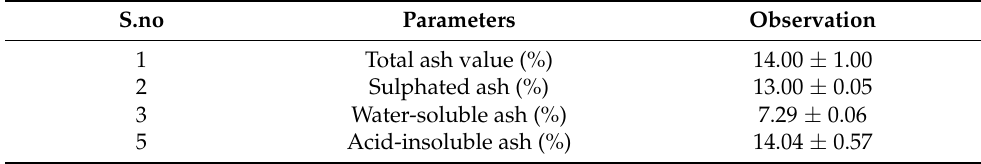
Table 3. Details of ash values of